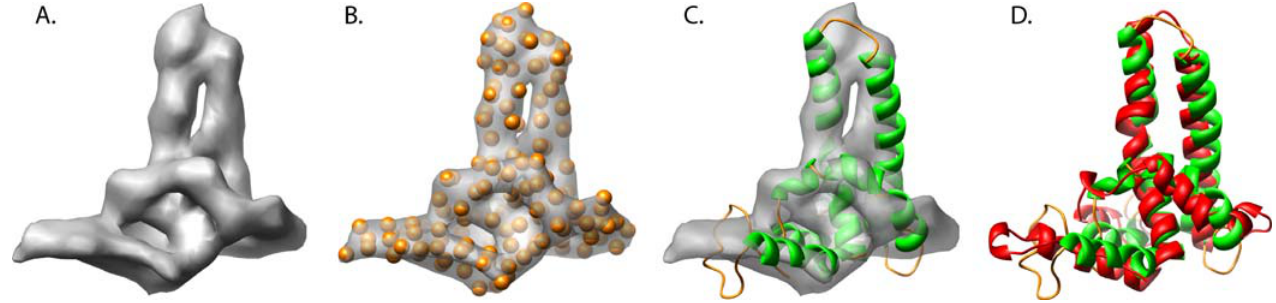
Figure 1. Modeling the Hepatitis B Capsid Protein The simulated density map of the hepatitis B virus capsid protein at 7.5-A˚ resolution is shown in grey (A). A reduced representation of the density map (orange spheres) is shown superimposed on the hepatitis B capsid protein density (B). The best decoy (6072) based on the described hybrid modeling protocol is shown superimposed on the simulated density (C). A comparison of the model structure (green-orange) and actual hepatitis B Virus capsid protein (red) is shown in (D). DOI: